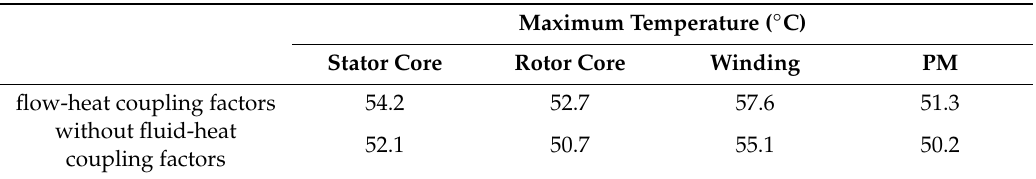
Table 5. Comparison of IWM maximum temperature.